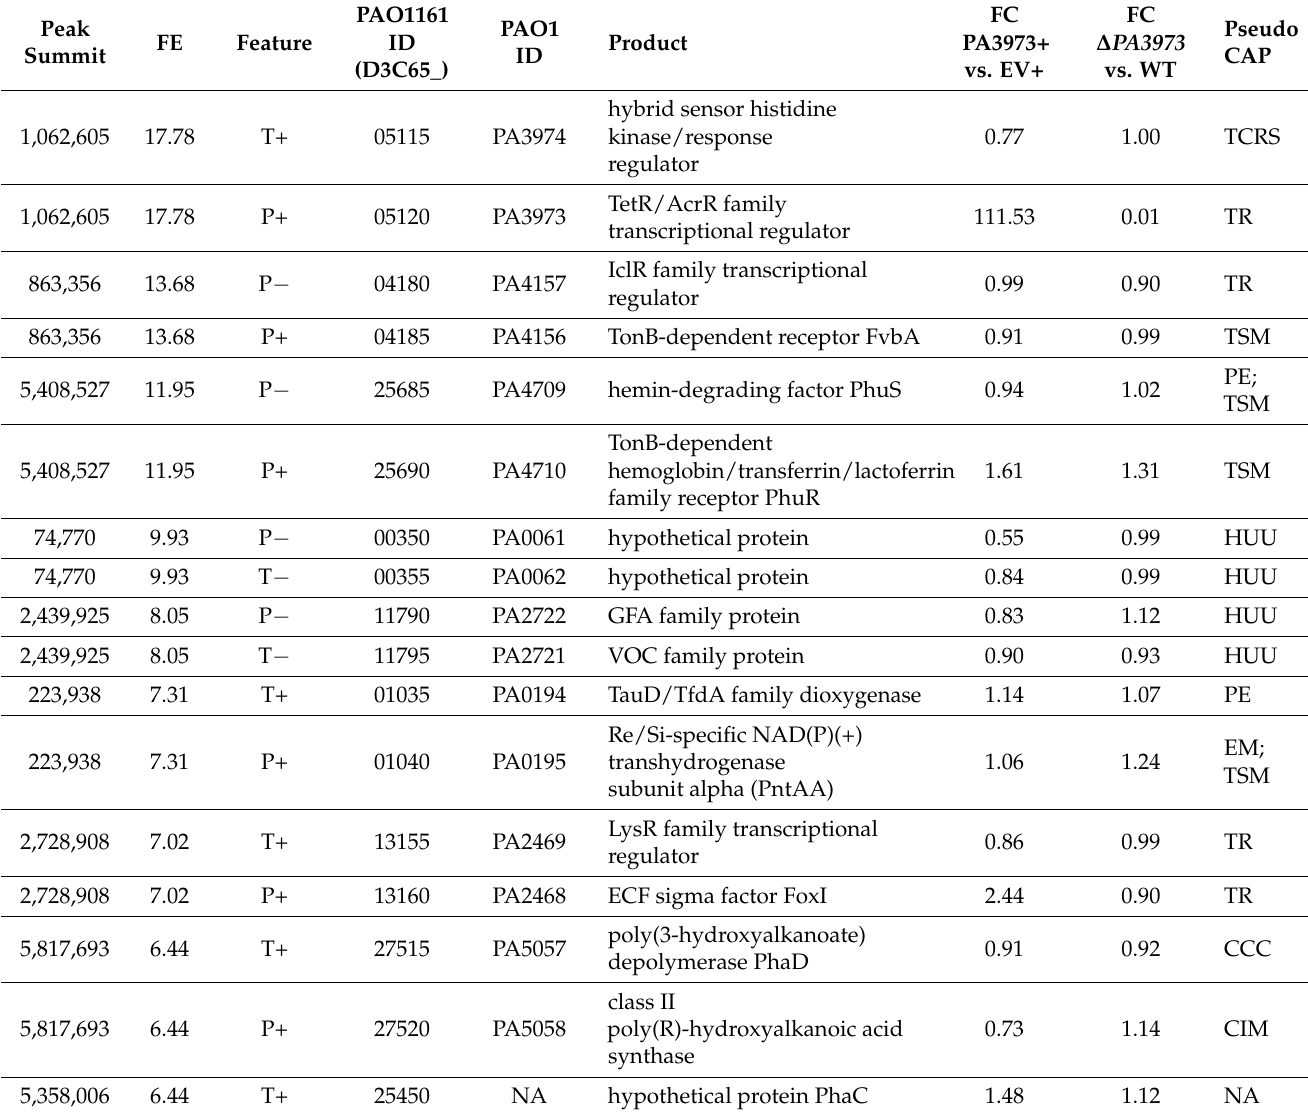
Table A1. List of the most enriched PA3973 bound sites identified in the P. aeruginosa PAO1161 genome (FE > 4). Abbreviations: P-promoter; T-terminator; gb-gene body; +/ − strand in